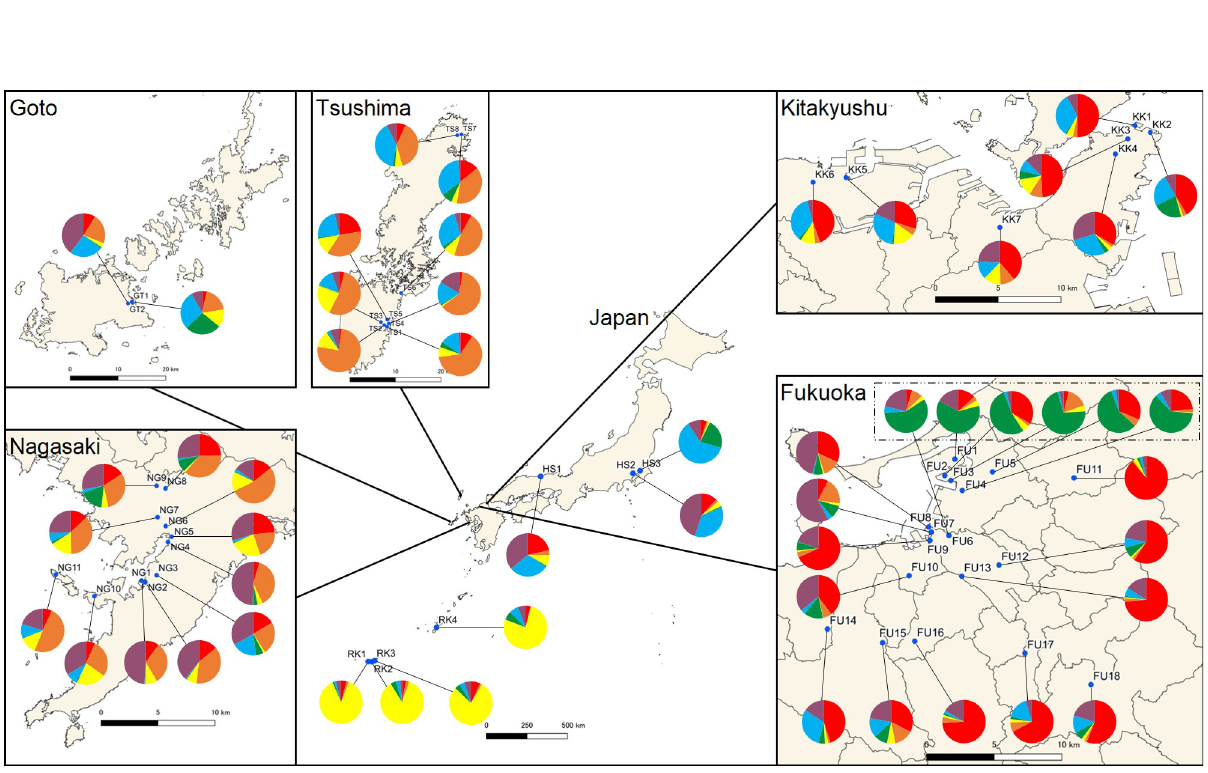
Fig 3. Bayesian membership assignment of Ae . albopictus populations in Japan with K = 6. Red: cluster 1; orange: cluster 2; yellow: cluster 3; green: cluster 4; blue: cluster 5; and purple: cluster 6. Fukuoka A is enclosed in dashed line. Created by processing Free vector and raster map data @ naturalearthdata.com and National Land Numerical Information (Administrative Area Data) @ Ministry of Land, Infrastructure, Transport and Tourism, Japan (https://nlftp.mlit.go.jp/ksj/gml/datalist/KsjTmplt-N03-v3_0.html).